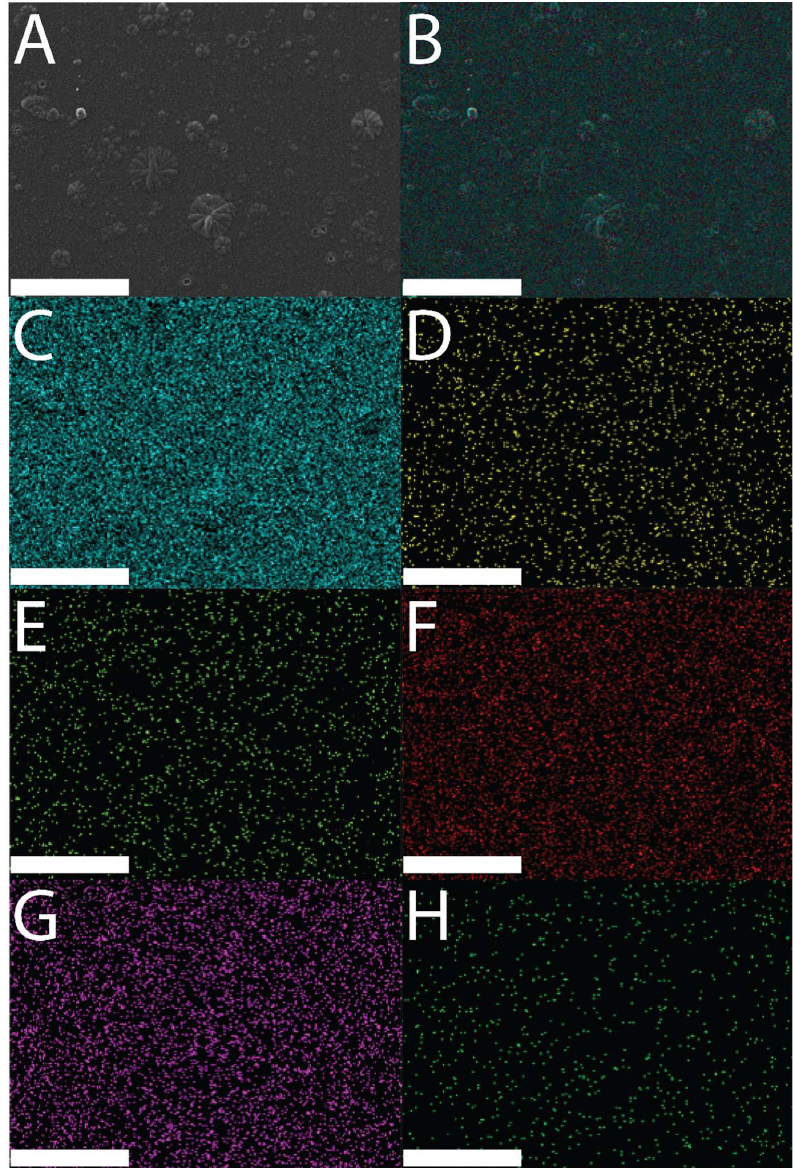
Figure 2. Scanning electron microscopy (SEM) and energy dispersive X-ray spectroscopy (EDX) images of a DMP-doped PPY film: ( A ) SEM image of a DMP-doped PPY film; ( B ) EDX layered image from a DMP-doped PPY film; ( C ) Kα emission of C; ( D ) Kα emission of F; ( E ) Kα emission of N; ( F ) Kα emission of O; ( G ) Kα emission of P; ( H ) Kα emission of Si. Scale bars represent 100 µm.